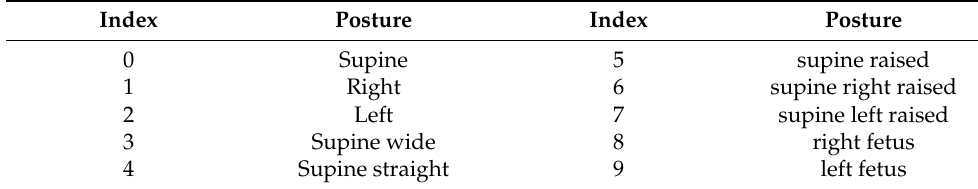
Table 2. Overview of the ten postures that were analyzed with the ConvLSTM model (extracted postures are from